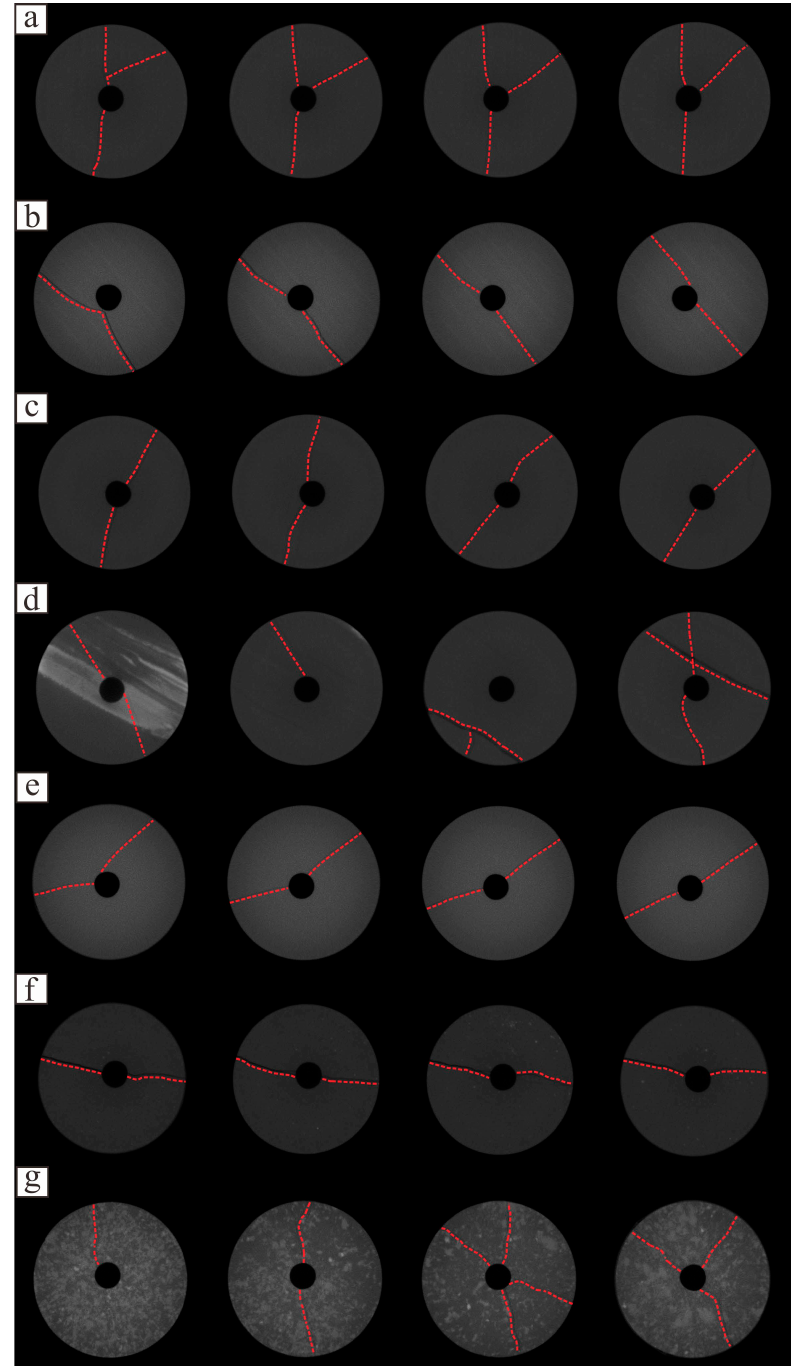
Figure 7. Typical CT scanning images of fractured shale ( a – e ); sandstone ( f ) and granite cores ( g ) CT scanning showing a vertical slice through the middle of the sample.